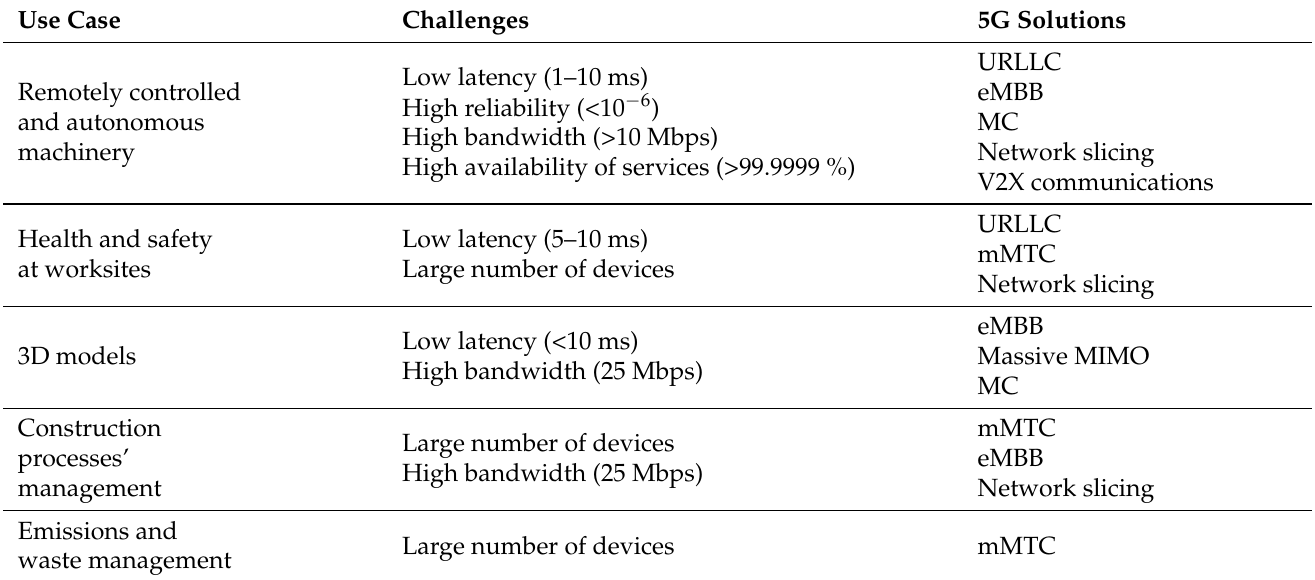
Table 1. 5G solutions for the construction industry use